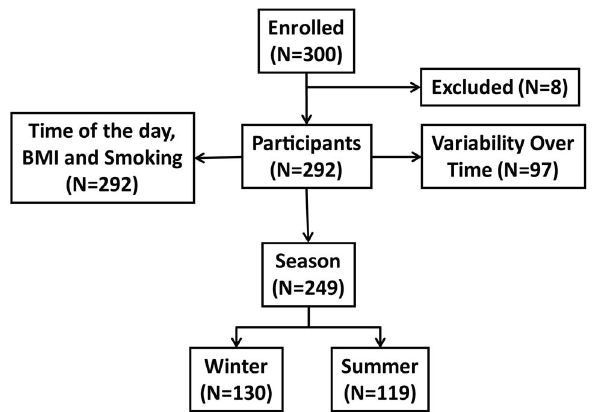
Figure 1. Study Design. From 300 subjects enrolled in the study, 292 were selected after quality control for being included in the study. All 292 were used in the evaluation of the effects of time of the day during sample collection, BMI, and smoking. For the evaluation of differences in melatonin levels according to season, 130 subject whose samples were collected during the winter and 119 subjects whose samples were collected during the summer were selected (Total=249 subjects). Samples collected from 97 subjects in 4 different time points were used to evaluate changes in melatonin levels over time.